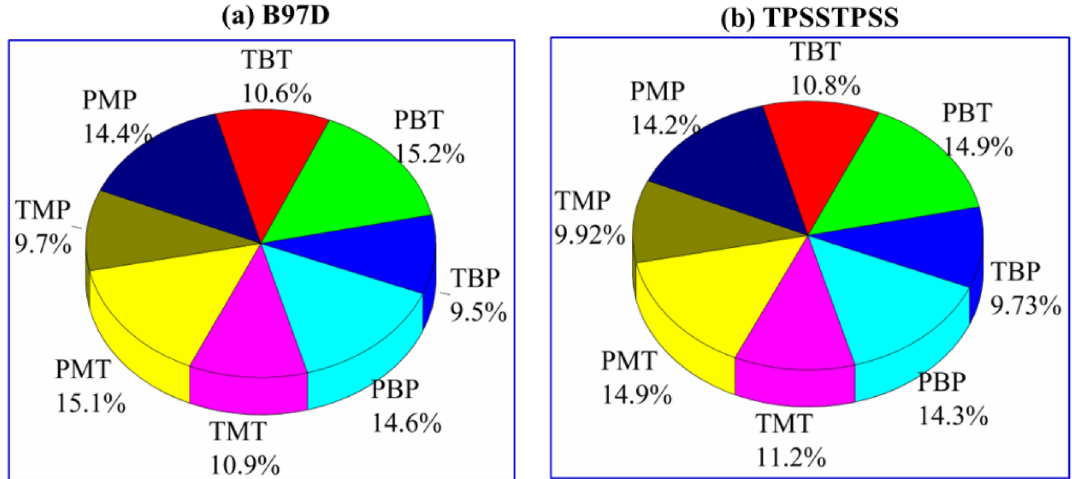
Figure 5. 3-D color Pie chart of the computed root mean square error (RMSE) for the 1 H-NMR chemical shifts of the 3-methyl-1-phenyl-4-(phenyldiazenyl)-1H-pyrazol-5-amine compound as obtained using B97D ( a ) and TPSSTPSS ( b ) functionals based on eight different combinations of geometry and bases